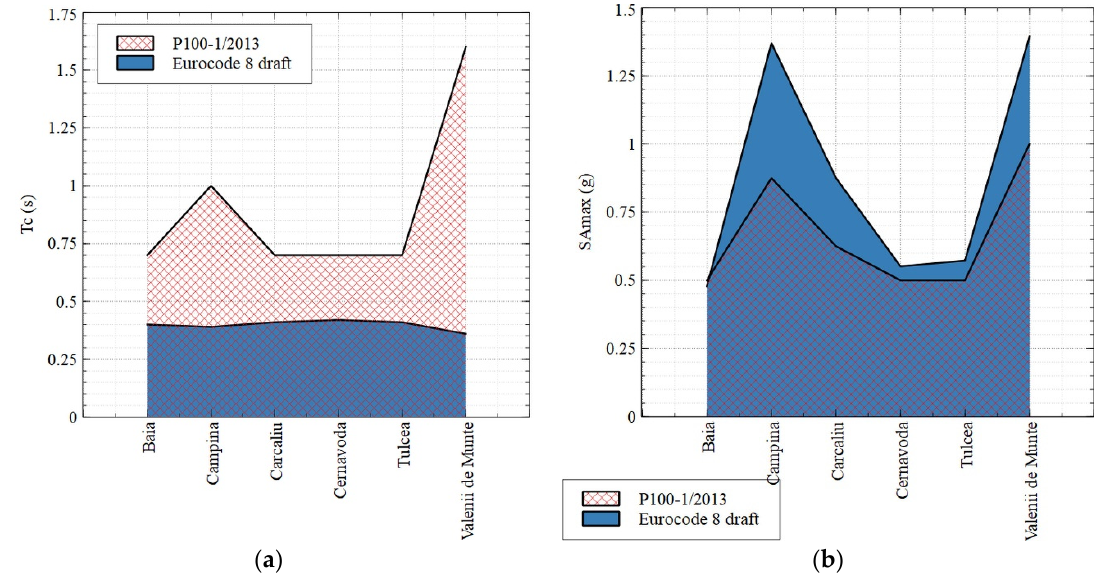
Figure 4. ( a ) A comparison between the control period T C from P100-1/2013 [29] and based on Eurocode 8 draft revision [1] for category B sites; ( b ) a comparison between the maximum spectral acceleration from P100-1/2013 [29] and based on Eurocode 8 draft revision [1] for category B sites.